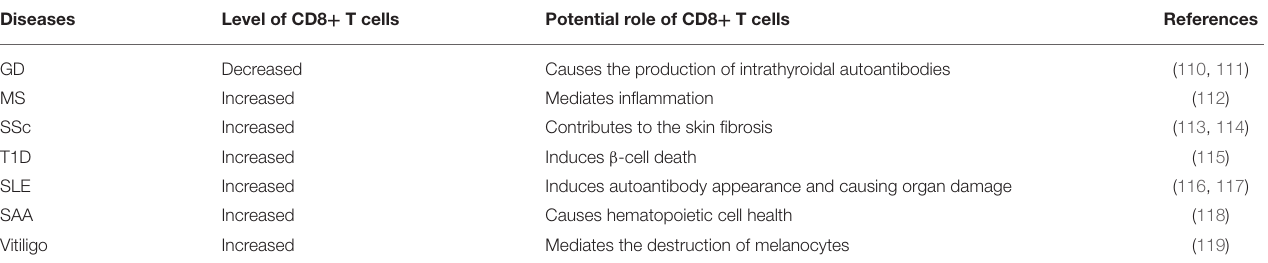
TABLE 1 | The potential role of CD8 + T cells in different autoimmune